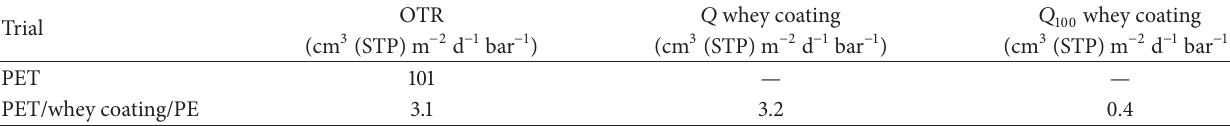
Table 2: Results of the optical measurement of the oxygen barrier.